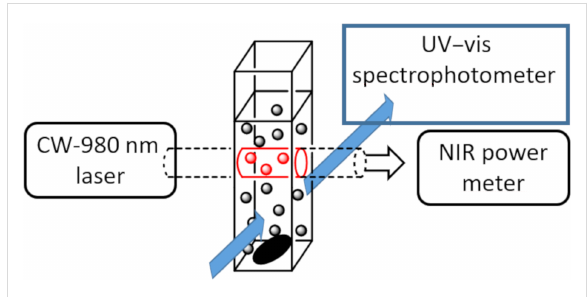
Figure 2: UCNPs (black dots) are irradiated inside the cylindrical CW 976 nm laser beam. Absorbed laser power is recorded with a power- meter. The UV–vis spectrophotometer axis is perpendicular to the laser